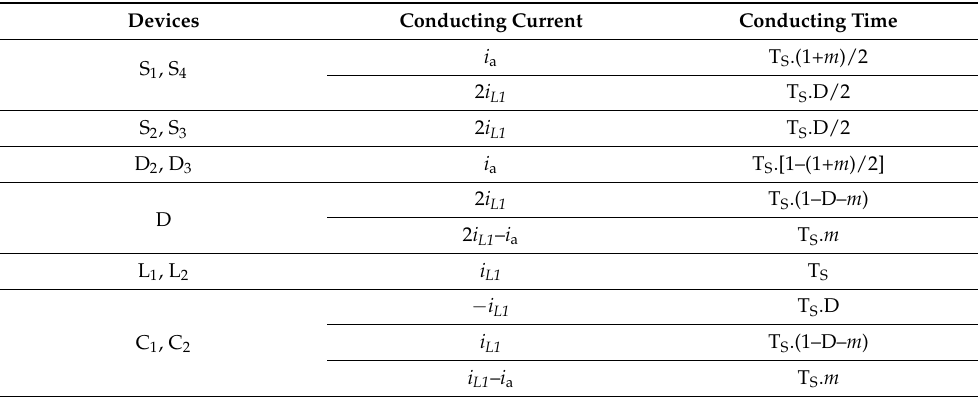
Table 9. Devices, conducting currents, and conducting time durations of the qZSI module in one switching cycle for the positive half fundamental cycle.